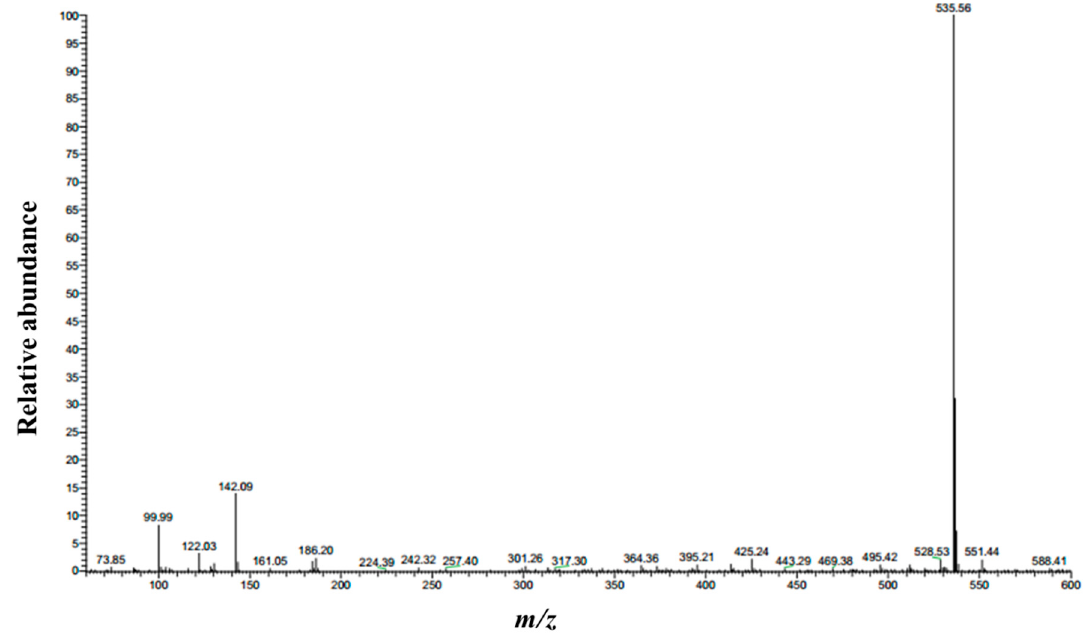
Figure 5. Mass spectrum of 1,3-LP. The [M + Na] + peak was observed at m / z 535.56.